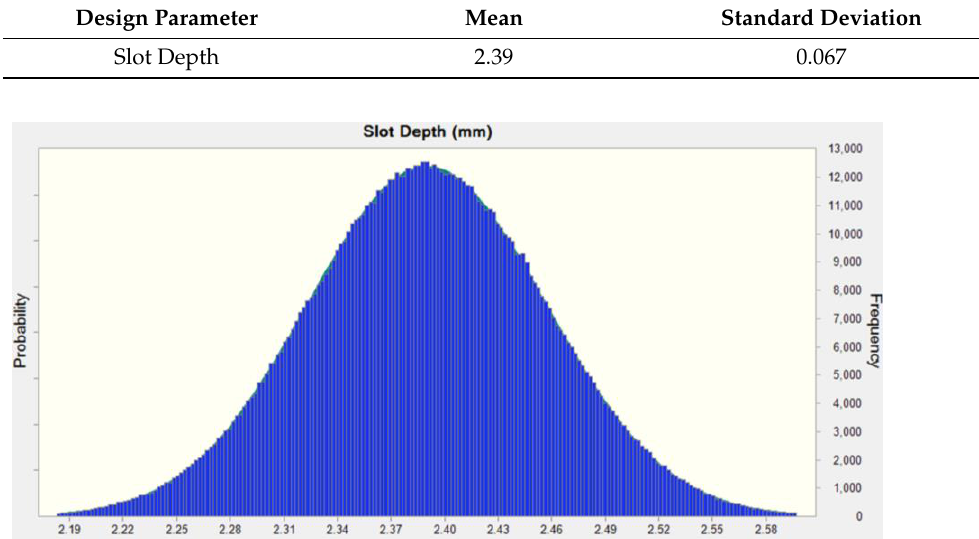
Figure 18. Probability normal distribution for the slot depth.